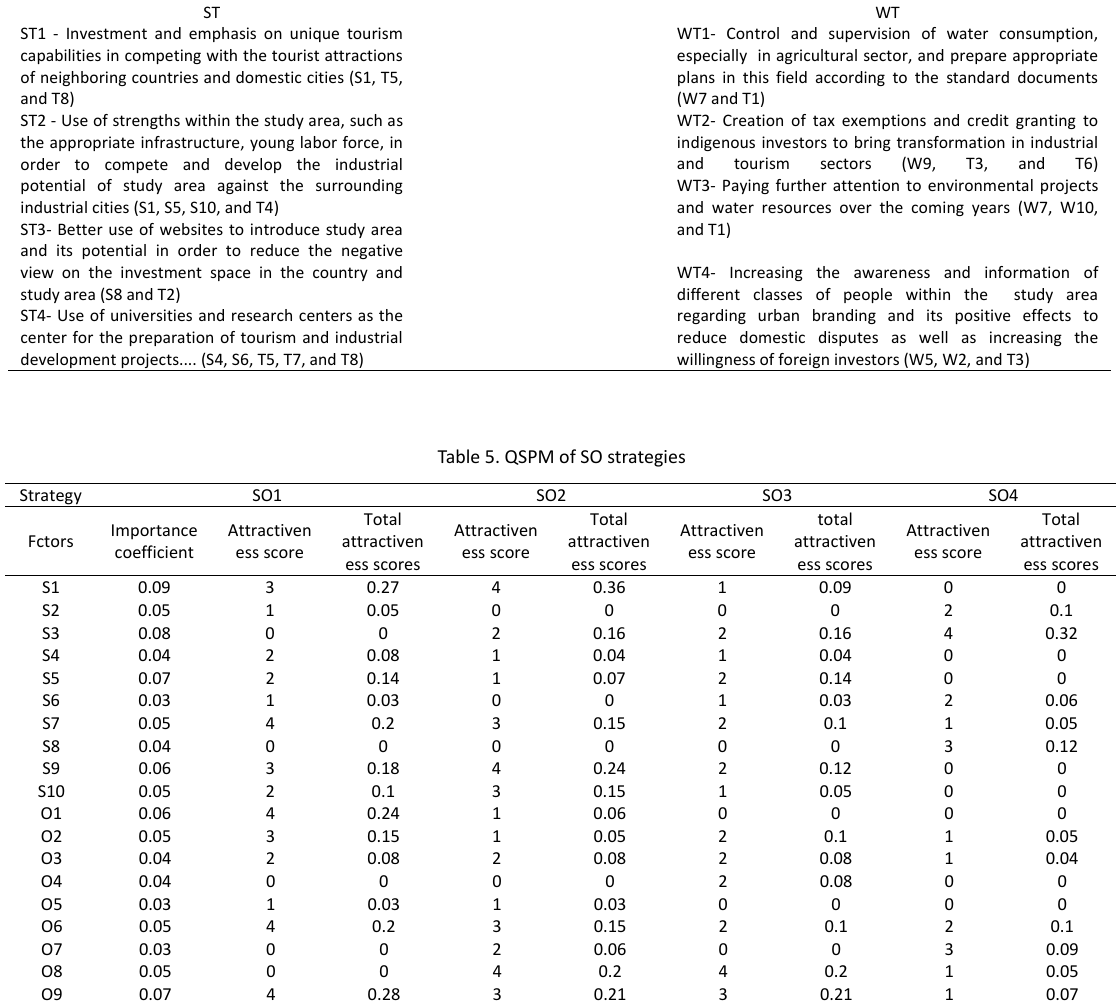
Table 5: QSPM of SO strategies